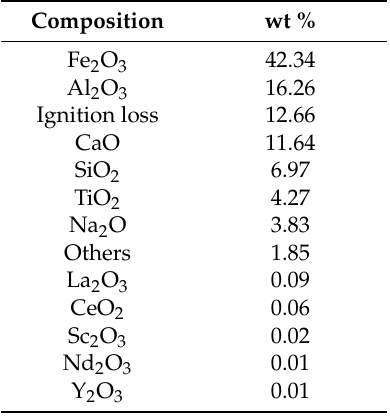
Table 1. Chemical composition of red